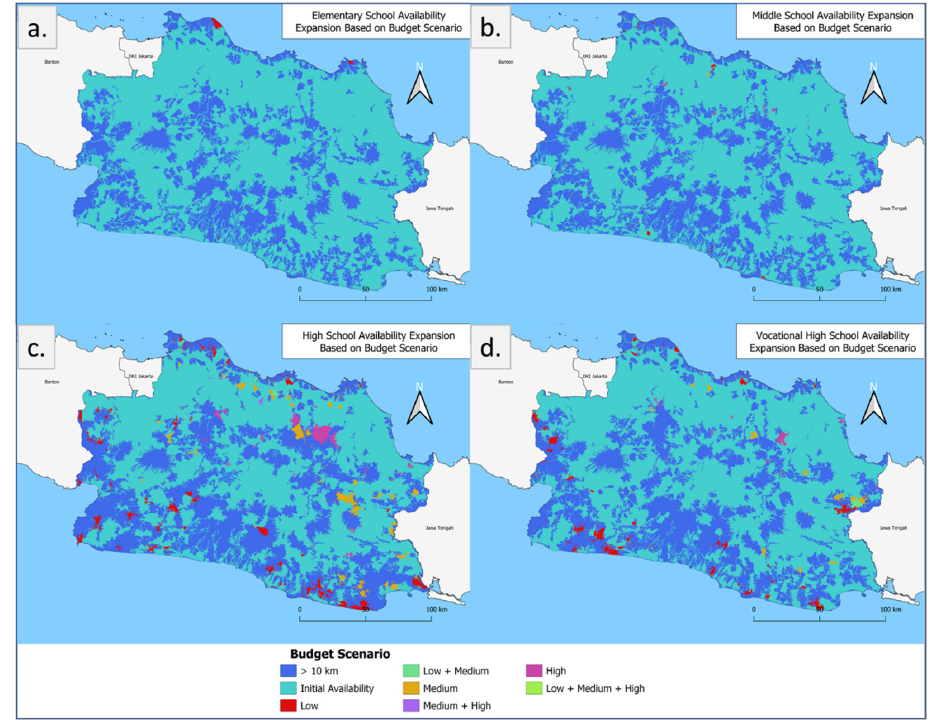
Figure 19. Expansion of school availability by budget scenario: ( a ) elementary, ( b ) junior high, ( c ) senior high, and ( d ) vocational high schools.